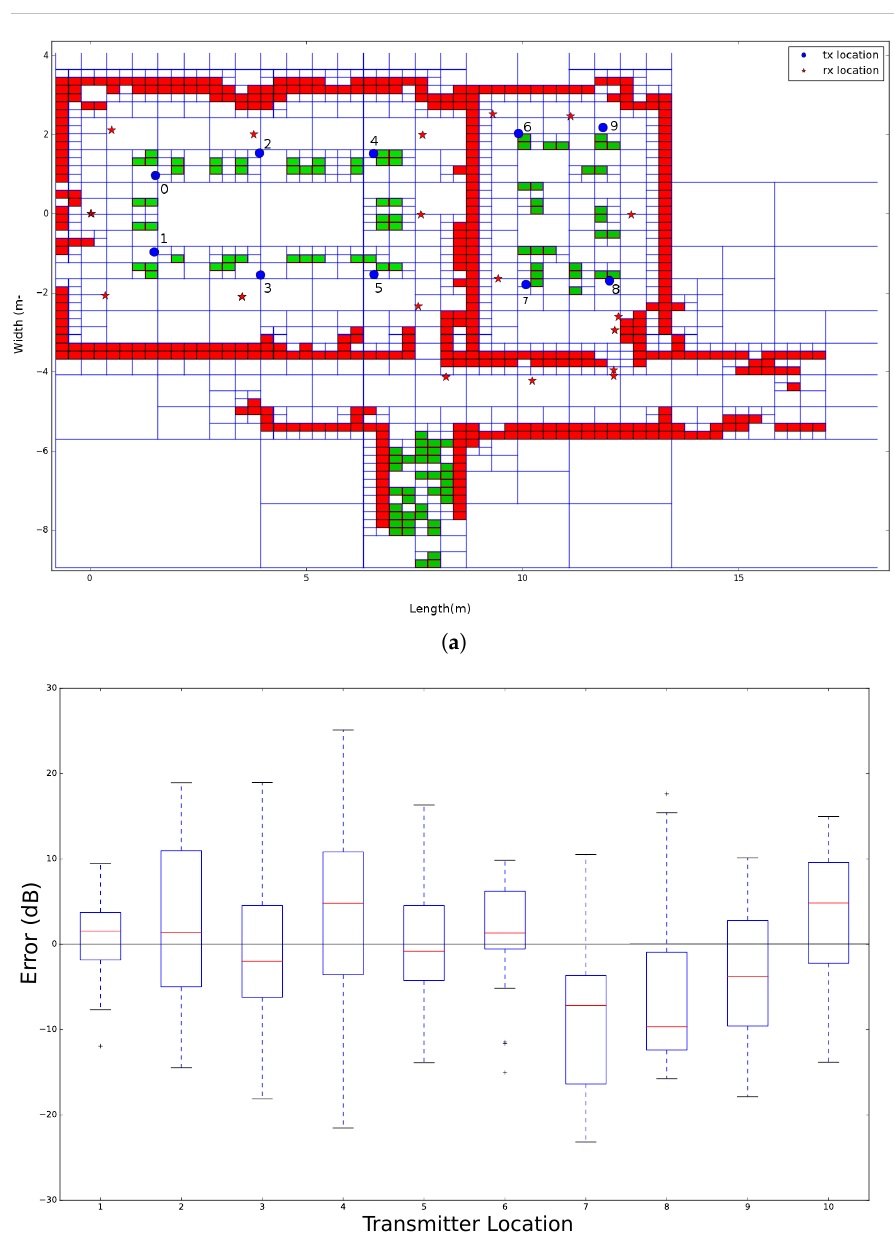
Figure 28. Office environment model 2. ( a ) environment model where blue dots are indicating the transmitter locations and the red stars are indicating the transmitter locations. Next, the green cells represent objects and the red cells represent a wall; ( b ) validation of each individual